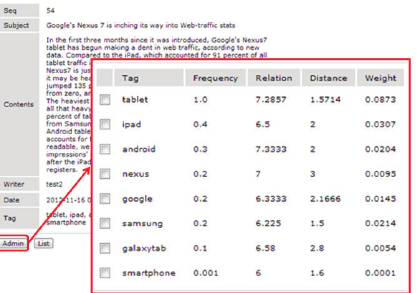
Figure 9: Administrator screen.